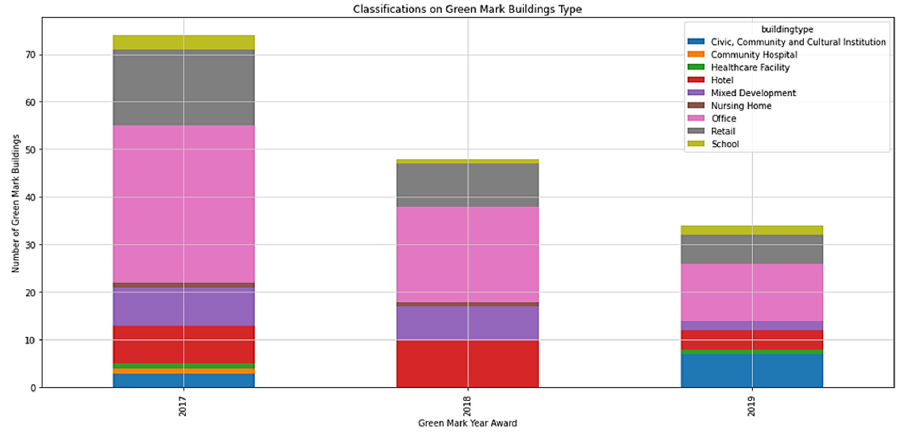
Figure 12. Classifications of Green Mark buildings in various industry sectors.